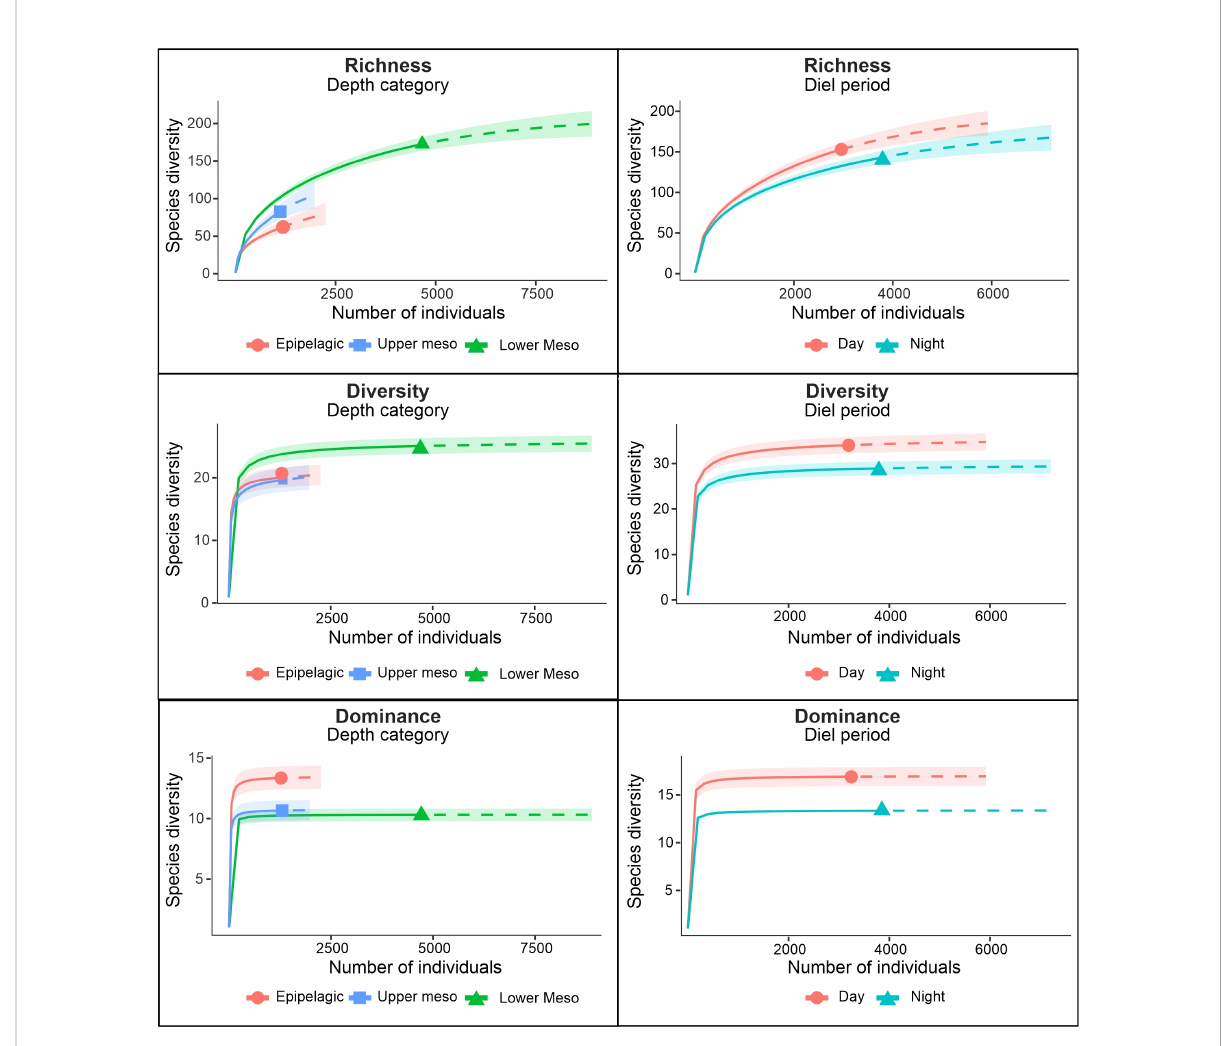
FIGURE 4 Sample-size-based rarefaction (solid line segment) and extrapolation (dotted line segments) sampling curves for species richness, diversity, and dominance of mesopelagic fi sh data at different depth categories and diel periods. Curves include the con fi dence intervals of 95% (shaded areas). For this analysis, only species recorded in the ABRACOS 2 survey were